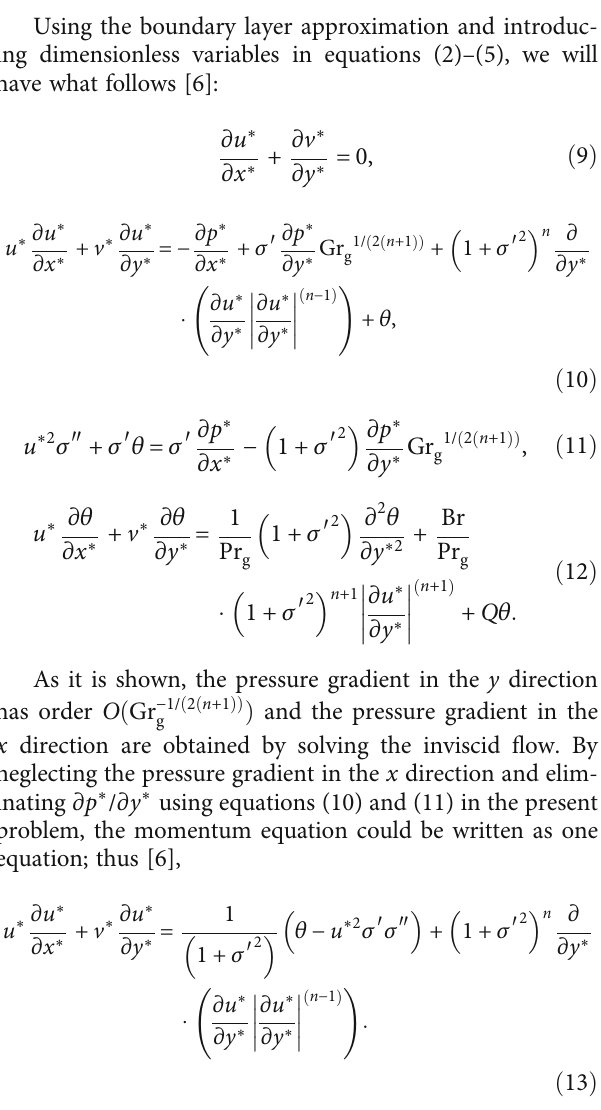
ffiffiffiffiffiffiffiffiffiffiffiffiffiffiffi p : Lg βΔ T ð 8